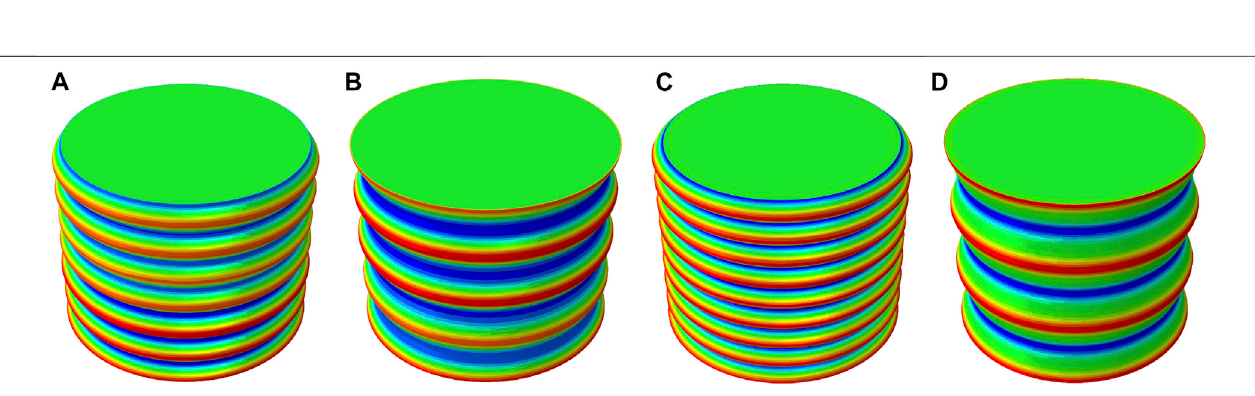
FIGURE 5 | Wrinkling patterns for a soft cylinder covered by a bilayer: (A) and (B) for the system with a varied Poisson ’ s ratio and the modulus ratios E i / E s = 11.0 and 12.0, respectively; (C) and (D) for the system with a fi xed Poisson ’ s ratio and E i / E s = 16.5 and 17.5, respectively.